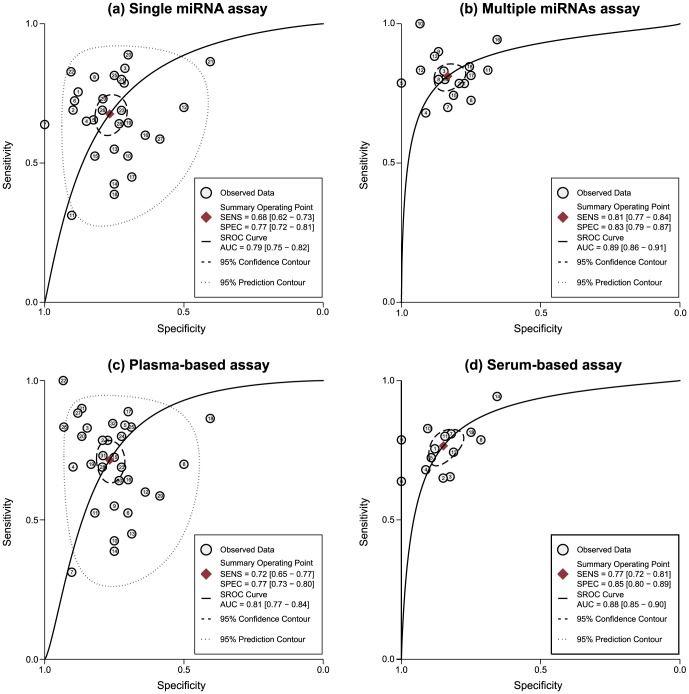
SROC curve with pooled estimates of sensitivity, specificity and AUC on the diagnostic value of circulating miRNAs in CRC detection (a: single-miRNA assay; b: multiple-miRNAs assay; c: plasma-based assay; d: serum-based assay).